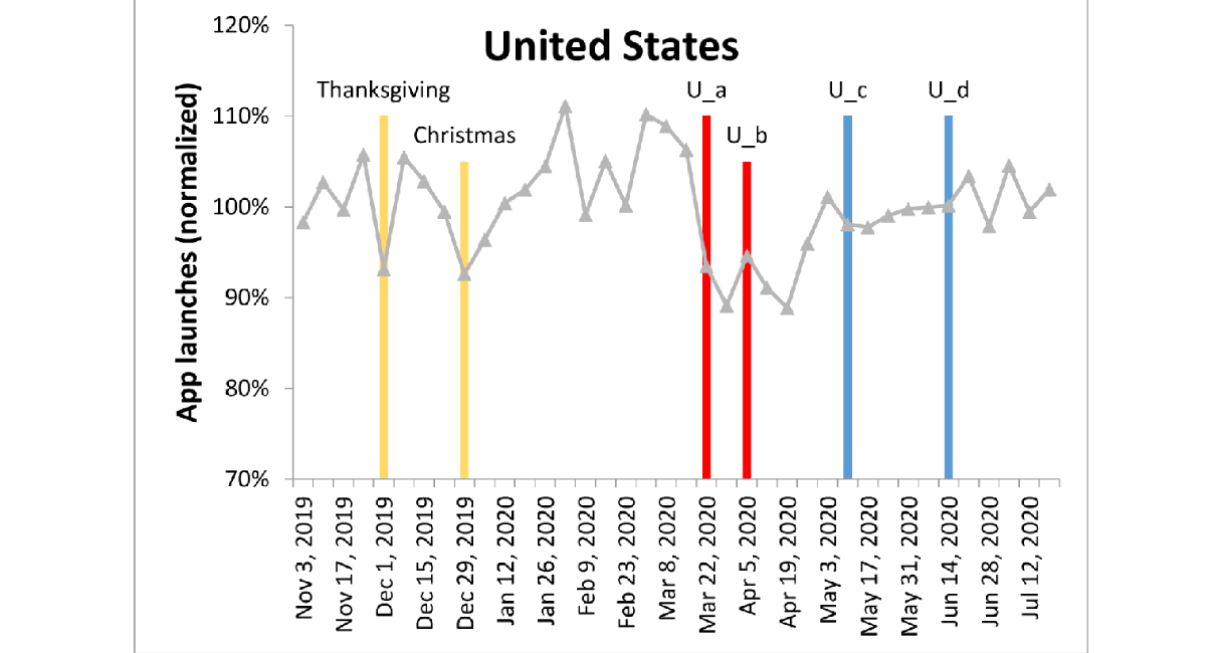
Figure 4. App launches in the United States, color-coded as in Figure 3. U_a: New York City public schools closed, and California issued a stay-at-home order for all 40 million residents. U_b: approximately 91% of people in the United States were instructed to stay at home. U_c: Florida and California reopened. U_d: New York City began phase I of